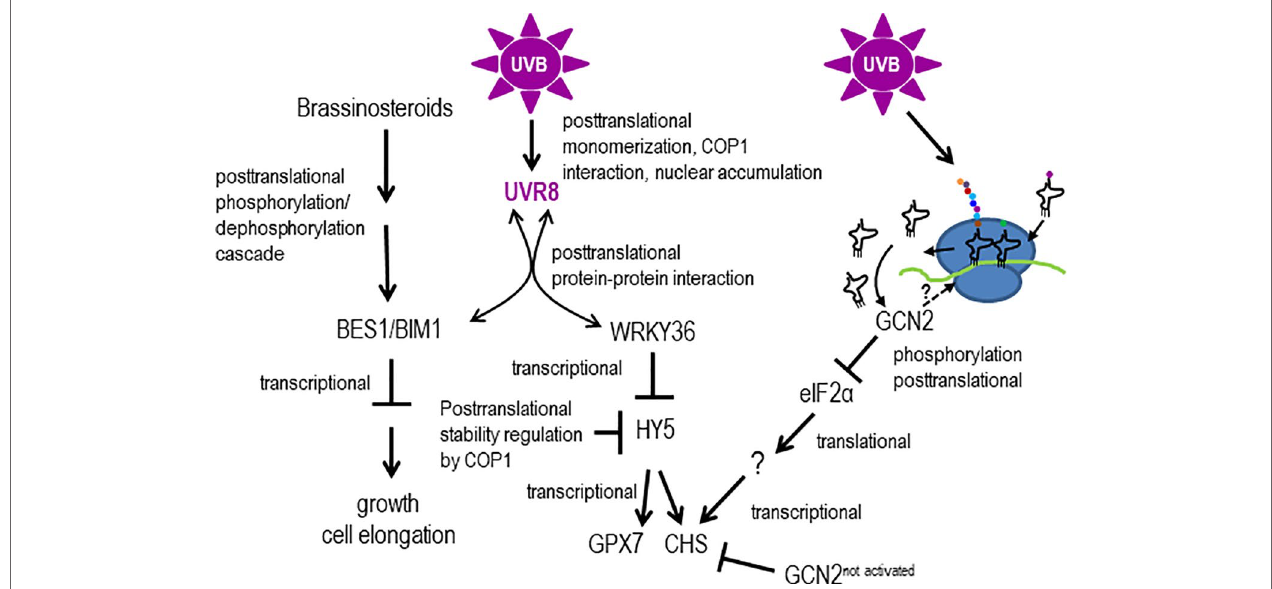
FIGURe 8 | Models hypothesizing, how GCN2 might regulate UV-B responses. UV-B responses are mediated by transcriptional and (post)translational control involving the UV-B photoreceptor UVR8 or not. UV-B triggers UVR8 monomerization, interaction with COP1 and changes of the subcellular compartment. In the nucleus, UVR8 directly interacts with the downstream transcription factors BES1/BIM1 and WRKY36. Interaction with BES1/BIM1 and WRKY36 titrates these transcription factors away from promoters of genes involved in cell elongation and growth and allows HY5 to bind to its own and UV-B responsive promoters. Unbound COP1 destabilizes HY5. UV-B induces posttranslationally the activity of GCN2 which might be activated through structural changes of ribosomes by RNA- protein crosslinking, overaccumulation of uncharged tRNAs or direct ribosome binding. Activated GCN2 phosphorylates eIF2α and thereby changing the population of translated mRNAs. Not activated GCN2 might indirectly repress the transcription of energy demanding biosynthesis genes such as CHS .